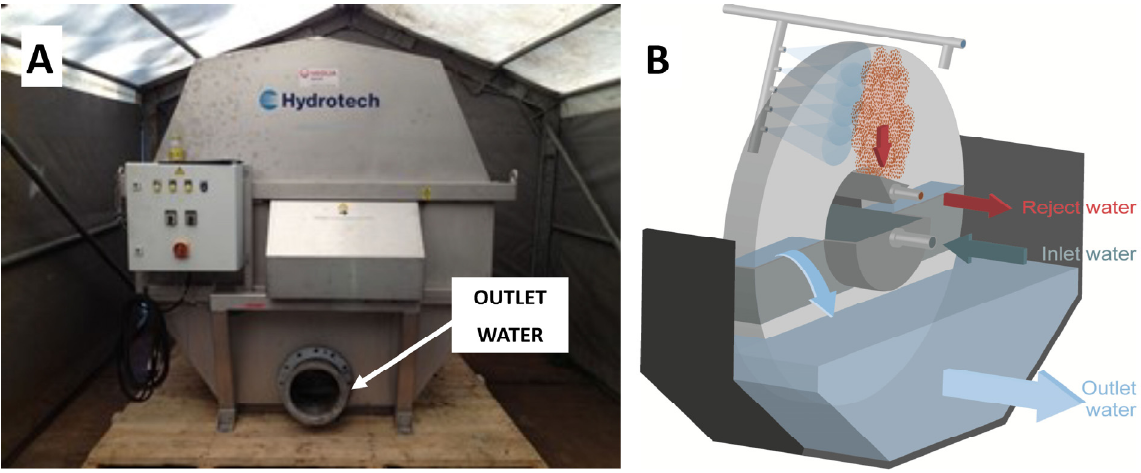
Figure 2. Schematic drawing of the treatment train. Stormwater runoff was pumped from the departed storm sewer into the ICBs, from where it entered the disc filter, and after cleaning, both the outlet water and the reject water was led back to the downstream